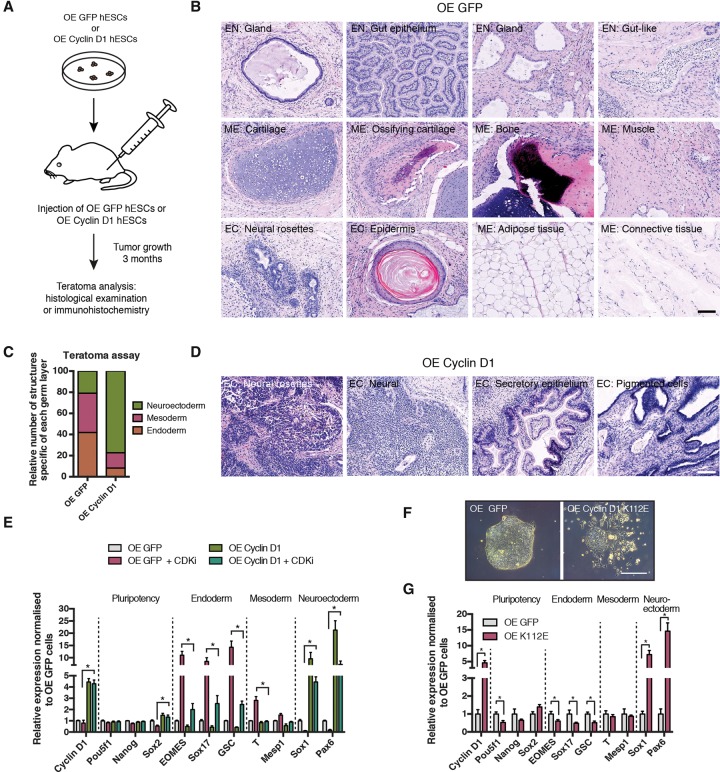
Cyclin D proteins can regulate cell fate decisions in hESCs independently of CDK4/6 activity. (A) Schematic overview of teratoma assay. (B) Histological sections of teratomas derived from GFP-overexpressing hESCs. (K) Kidney; (ME) mesoderm; (EN) endoderm; (NE) neuroectoderm. (C) Ratio of histological structures specific to each germ layer. X2= 152.5, Bonferroni corrected P < 6.6 × 10−16, χ2 test. (D) Histological sections of teratomas derived from Cyclin D1 overexpressing hESCs. (E) CDK4/6 inhibition does not fully abolish Cyclin D function. Significant differences calculated by two-way ANOVA are marked. (F) Morphology of a CycD1-K112E mutant overexpressing hESCs. Representative colonies of hESCs overexpressing GFP and CycD1-K112E. (G) The CycD1-K112E mutant, which is not able to activate CDK4/6, can block endoderm genes and induce neuroectoderm. Significant differences compared with overexpressing GFP and calculated by t-test are marked. All data are shown as mean ± SD. n = 3.